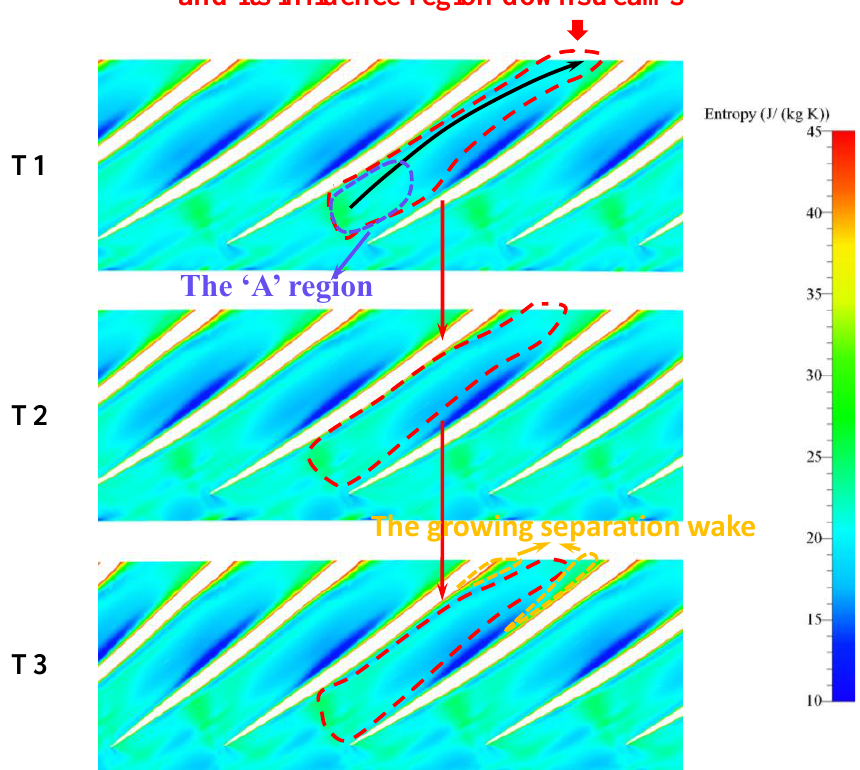
Figure 13. The entropy distribution within the R1 passage; unsteady CFD results .